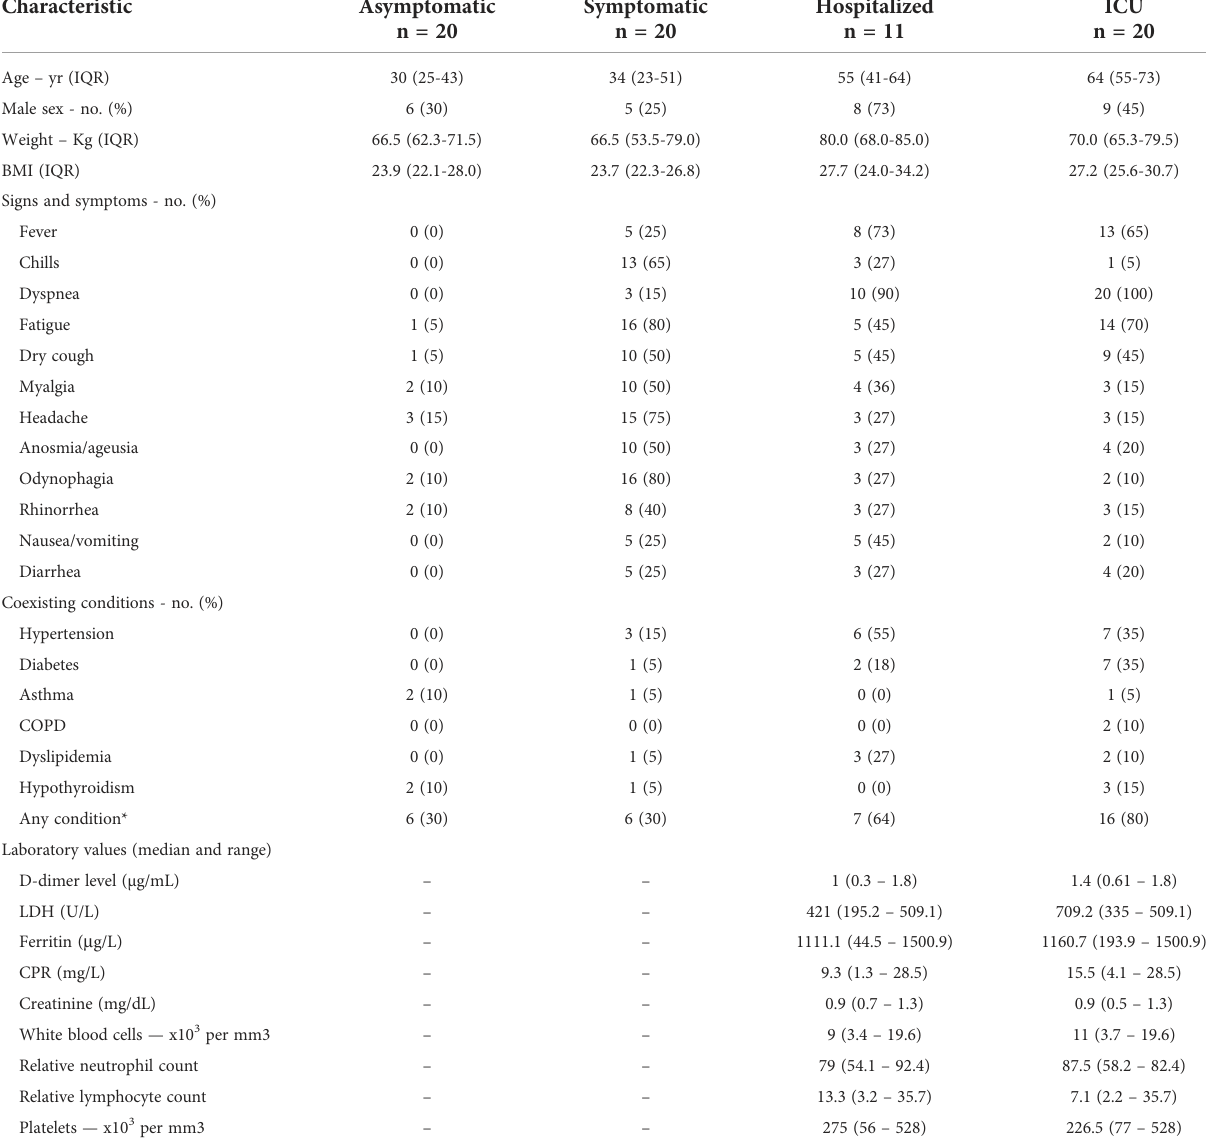
TABLE 1 Baseline sociodemographic and clinical characteristics. Characteristic